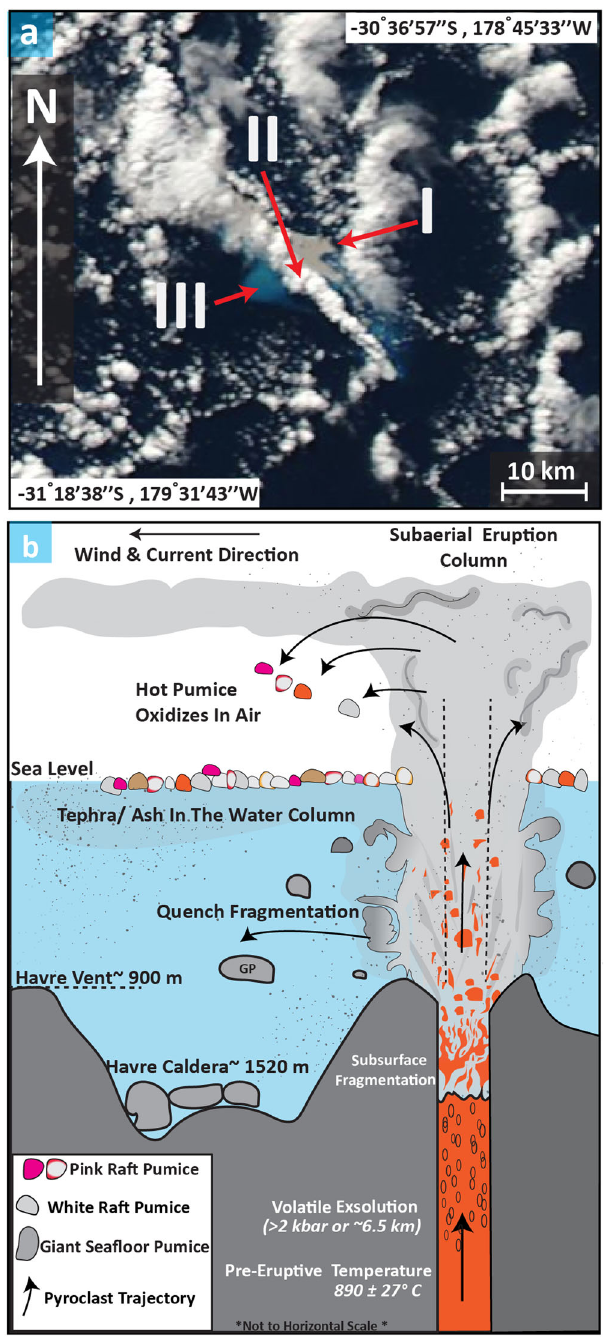
Fig. 6 2012 Havre explosive eruption model. a NASA Aqua Modis (Moderate-resolution imaging Spectroradiometer) satellite true colour image ~21 h after eruption onset (01:26 UTC July 18, 2012) showing the pumice raft (I) that had covered an area of ~400km 2 . 28,29 , a gas/steam vapour plume (II) extending ~50 km downwind, and suspended ash/tephra at shallow water depths (III) surrounding the pumice raft. b Eruption model showing an explosive eruption column triggered by exsolution of volatiles at depth, leading to subsurface magmatic volatile-driven fragmentation. Black arrows represent trajectories of pumice types examined in this study assuming the raft and giant sea fl oor pumice (GP) were